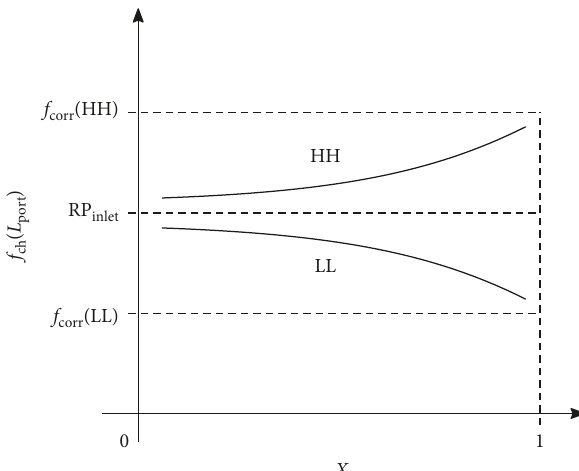
Figure 15: Inlet pressure drop ratio IR L ch ( port ) corrugated